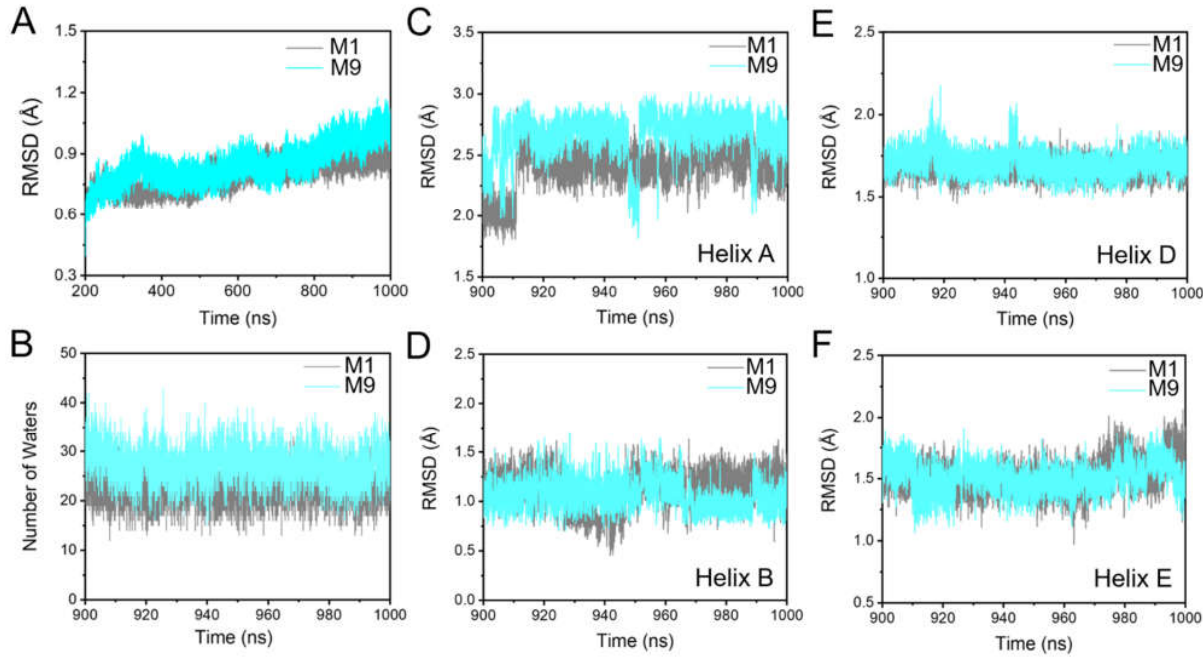
Figure 10. Dynamic changes in the helices and water molecules caused by the K40L mutation. ( A ) Time evolution of RMSD of the Cα atoms during the simulation of M1 and M9 (membrane of the K40L-bR trimer with POPC, S-TGA-1, and PGP-Me); ( B ) time series of the number of water molecules near the cytoplasmic surface in the last 100 ns simulations of M1 and M9; ( C – F ) the RMSD of the cytoplasmic end of helices A ( C ), B ( D ), D ( E ), and E ( F ) in M1 and M9 in a late M-state crystal structure (PDB ID: 1FBB). A smaller RMSD indicates a larger opening. Grey and cyan indicate the M1 and M9, respectively.